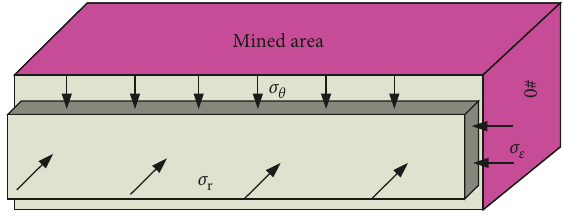
Figure 2: Pillars model of surrounding rock collapse area.